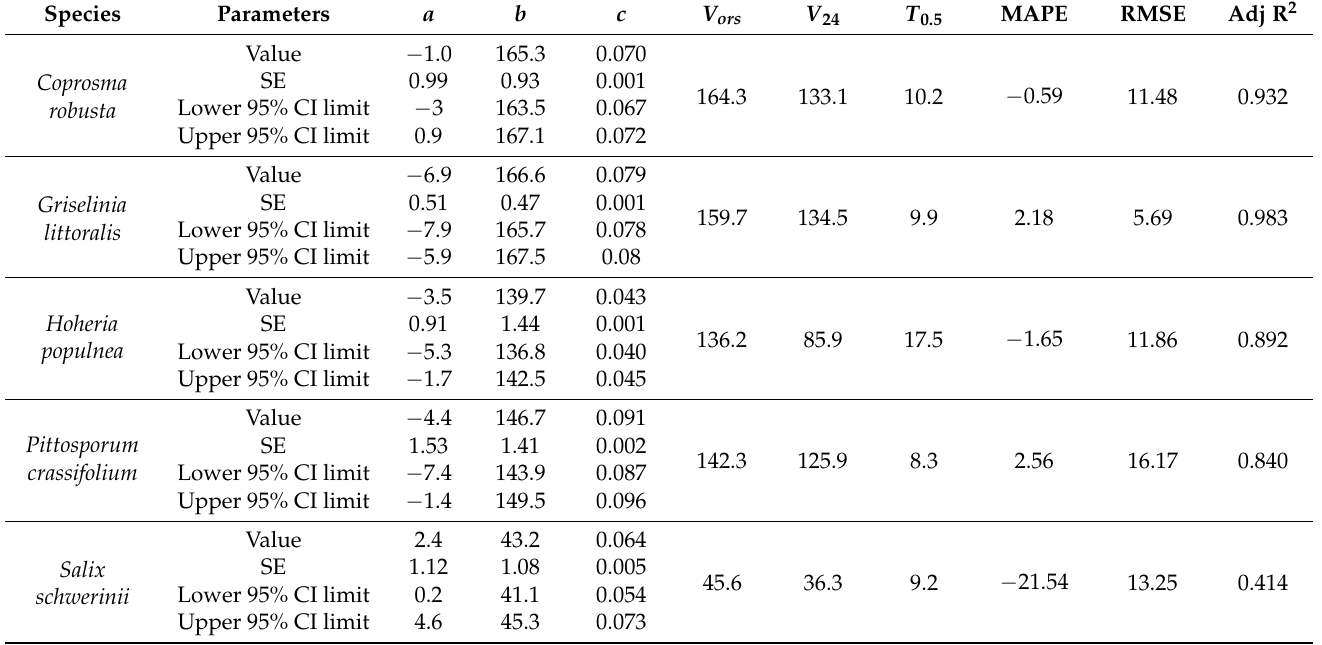
Table 5. Native ( Coprosma robusta, Griselinia littoralis, Hoheria populnea , and Pittosporum crassifolium ) and exotic ( Salix schwerinii ) shrub species leaf in vitro fermentation kinetic parameters derived using singlepool model, where: a , gas production from the immediately soluble fraction (mL/g DM); b , gas production from the slowly degradable fraction (mL/g DM); c , rate of gas production (%/h); V ors , total gas production (mL/g DM); V 24 , total gas production after 24 h (mL/g DM); and t 0.5, half-life of total gas production